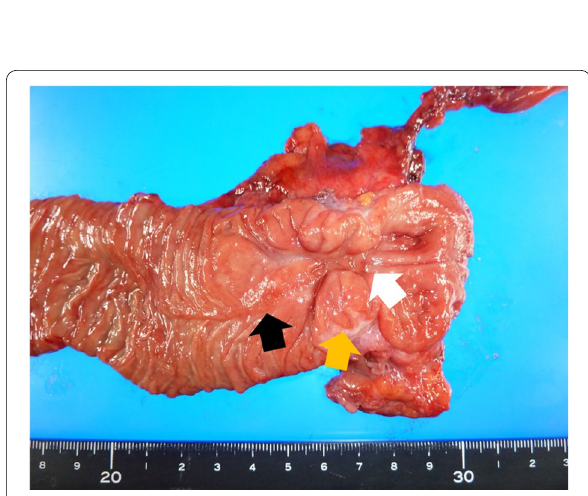
Fig. 4 Macroscopic examination of resected duodenum. Duodenal stenosis (white arrow), CBD opening (orange arrow), and papilla of Vater (black